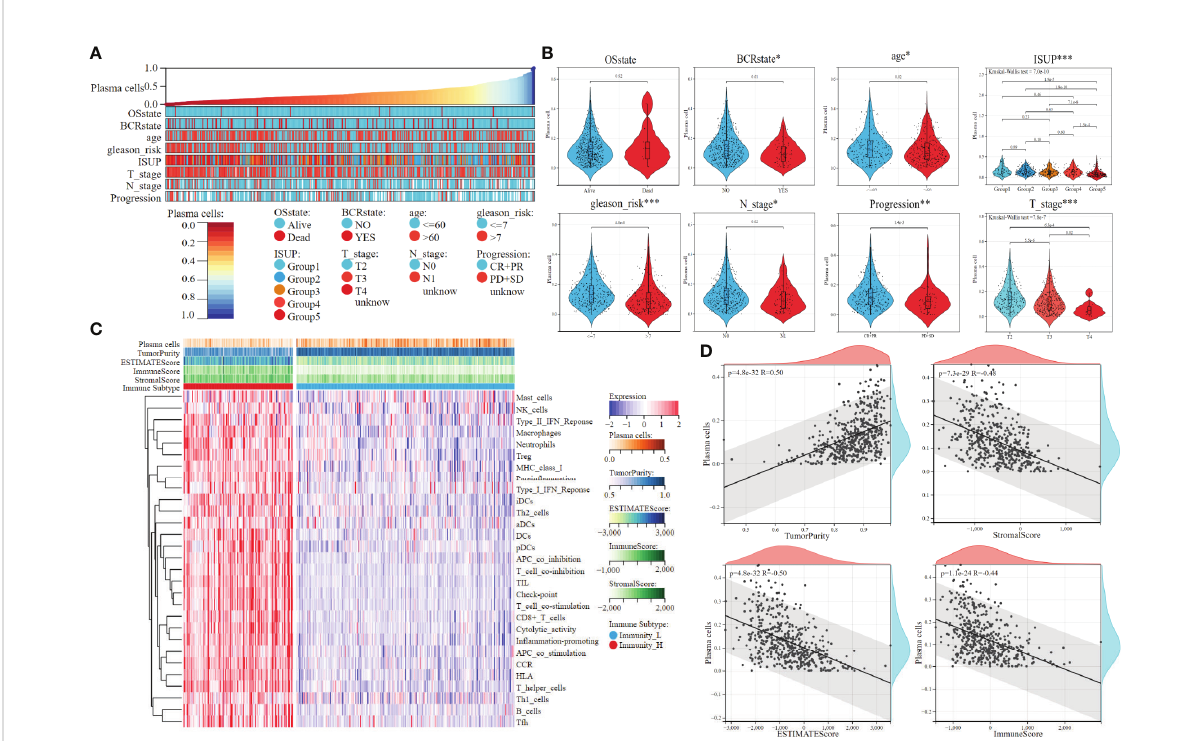
FIGURE 2 The clinical features and tumor microenvironment patterns associated with the plasma cell fraction in PCa patients. (A) The overview of the association between plasma cell fraction and clinical features of patiens. (B) Violin plots of plasma cell fraction in individual samples of PCa patiens, strati fi ed by clinical features. (C) The immune subtypes of PCa patiens were categorized on the basis of the overall immune activity. (D) Correlation analysis between plasma cell fraction and the tumor purity, stromal score, immune score and ESTIMATE score evaluated by ESTIMATE algorithm. *P < 0.05, **P < 0.01, ***P <